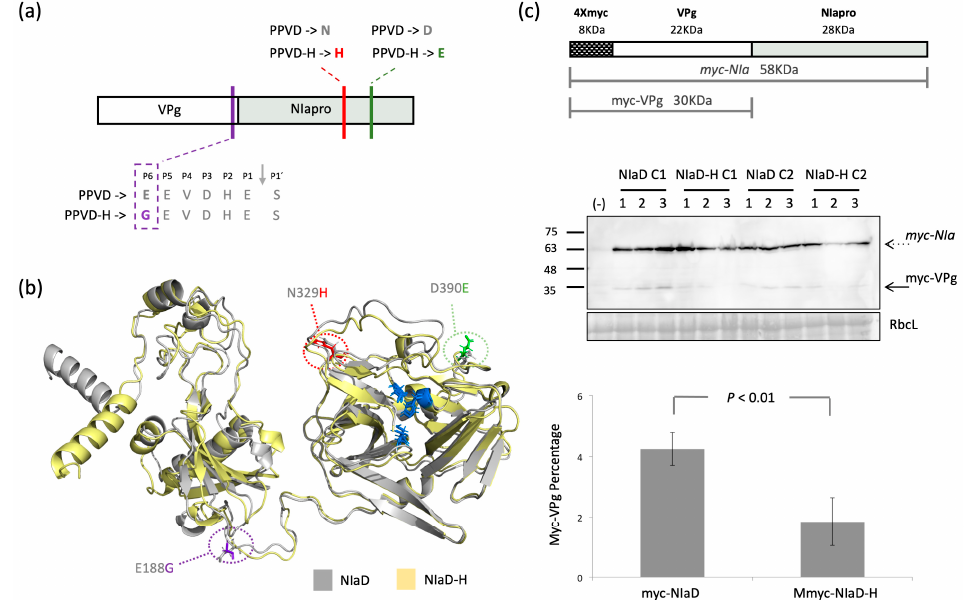
Figure 5. Study of individual mutations in NIa. ( a ) Schematic representation of NIa; mutations in PPVD-VPg, PPVD-NIa1H and PPVD-NIa2H are shown in purple, red and green, respectively; details on the sequence of the proteolytic cleavage site are shown in the case of the VPg change. ( b ) Comparison of the model of NIaD (gray) and NIaD-H (yellow) generated by Alphafold; amino acid changes are marked as sticks following the colors in ( a ); amino acids of the catalytic triad are shown as sticks and colored in blue. ( c ) Transient expression experiment of NIaD and NIaD-H; scheme of the expressed constructs with the corresponding sizes of each product in KDa is shown in the upper part; in the middle part, anti-myc immunoblot of protein extracts from tissue collected at 5 dpi from the different plants; numbers on top of each lane correspond to the number of the plant; C1 and C2 correspond to clone1 and clone 2, respectively; negative control, marked with ( − ), corresponds to a healthy N. benthamiana plant; estimated processed (in Roman text) and unprocessed (in italics) products are marked on the right with solid and dotted arrows, respectively; molecular weight markers are indicated (left; in KDa); a Ponceau red-stained blot (RbcL) is shown below each membrane as loading control; the lower part shows the quantification of the processing ratio from the immunoblot; the di ff erence is statistically signi fi cant ( p < 0.01) by Student(cid:31)s t -test (n = 6).